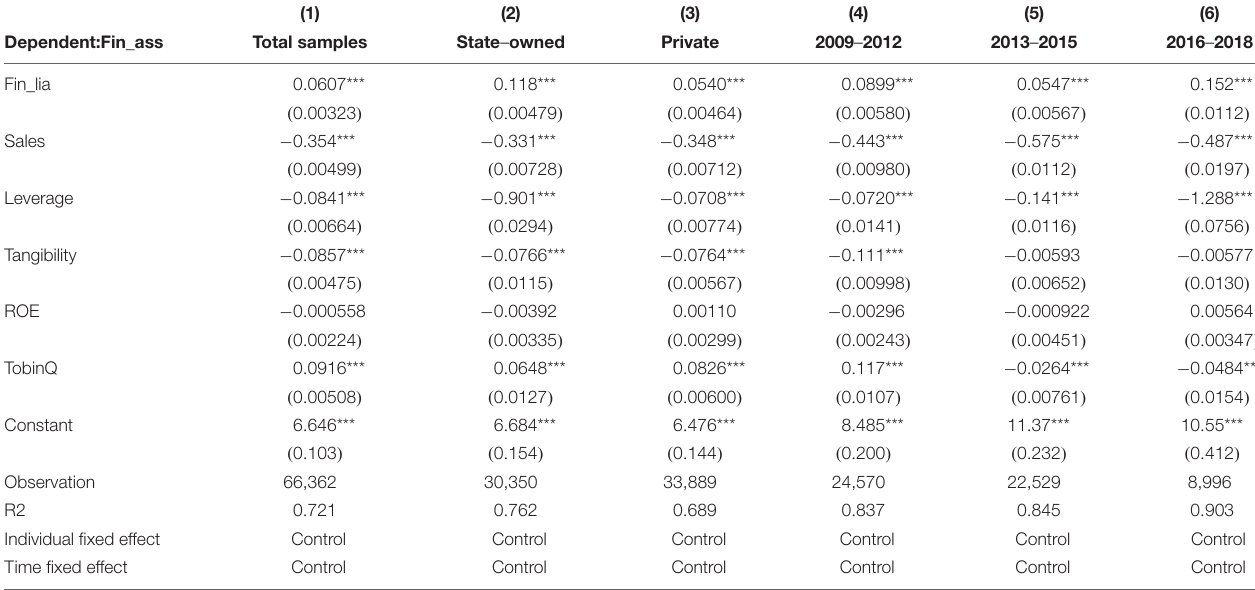
TABLE 2 | Secondary credit identification model